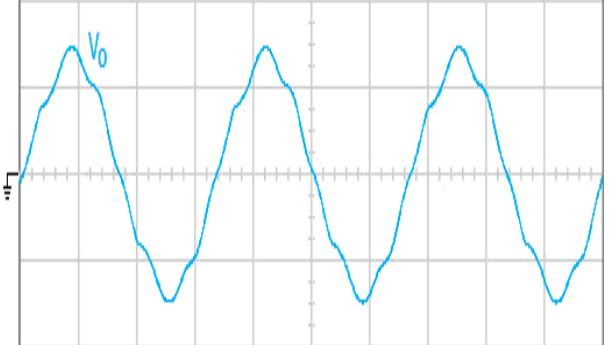
Figure 9. Experimental waveform of the output voltage under the variation of filter parameters L and C for the classical finite ‐ time convergent SMGL (100 V/div; 5 ms/div).